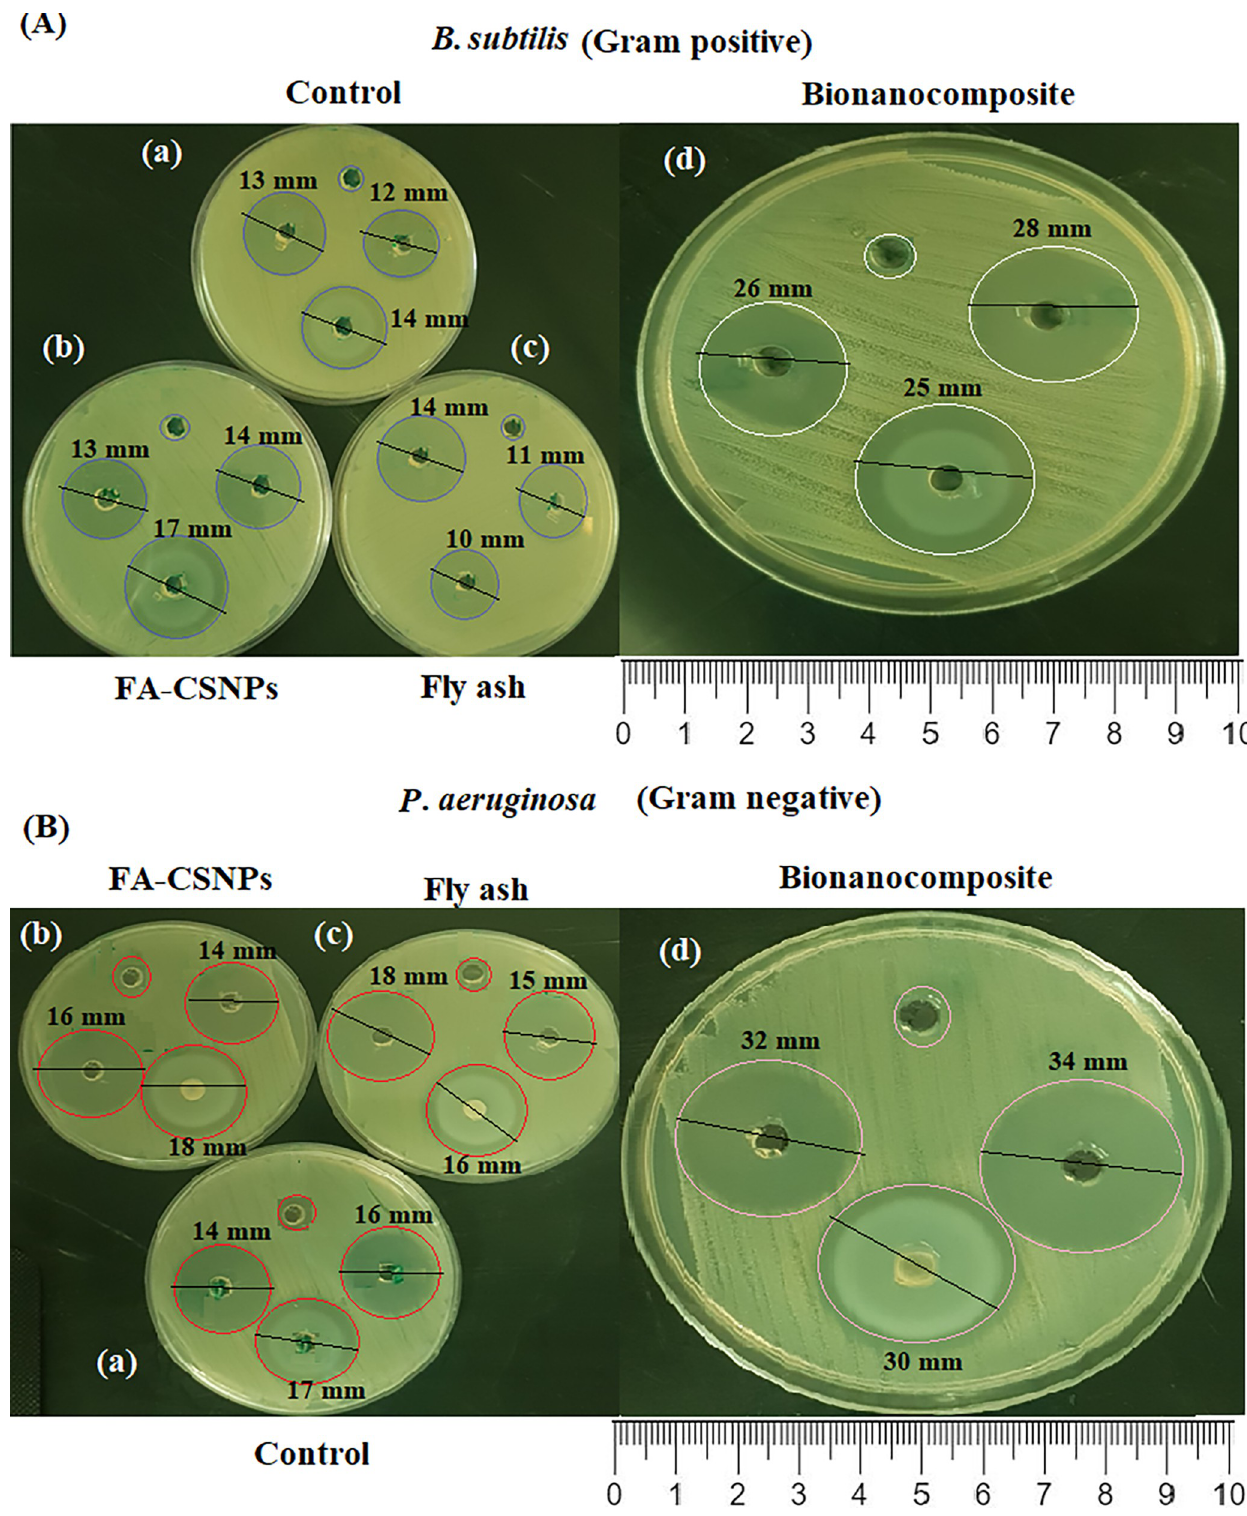
Fig 6. Antibacterial potential of (a) control, (b) FA–CSNPs, (c) fly ash, and (d) sunflower oil/FA–CSNPs bionanocomposite film against (A) B . subtilis and (B) P . aeruginosa strains.